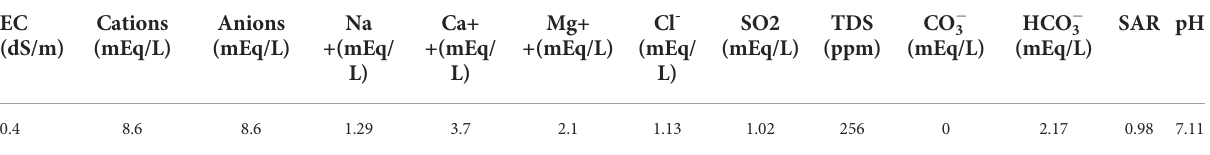
TABLE 2 Physiochemical analysis of soil.